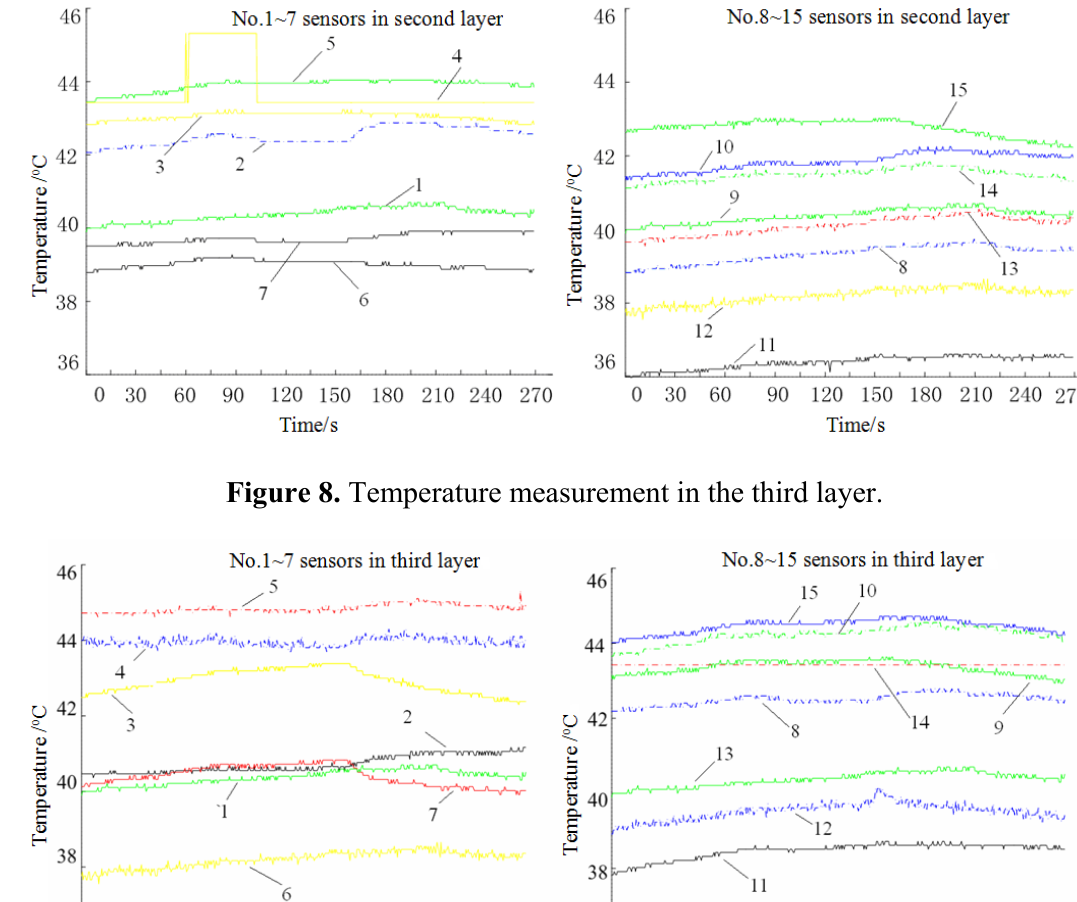
Figure 7. Temperature measurement in the second layer.